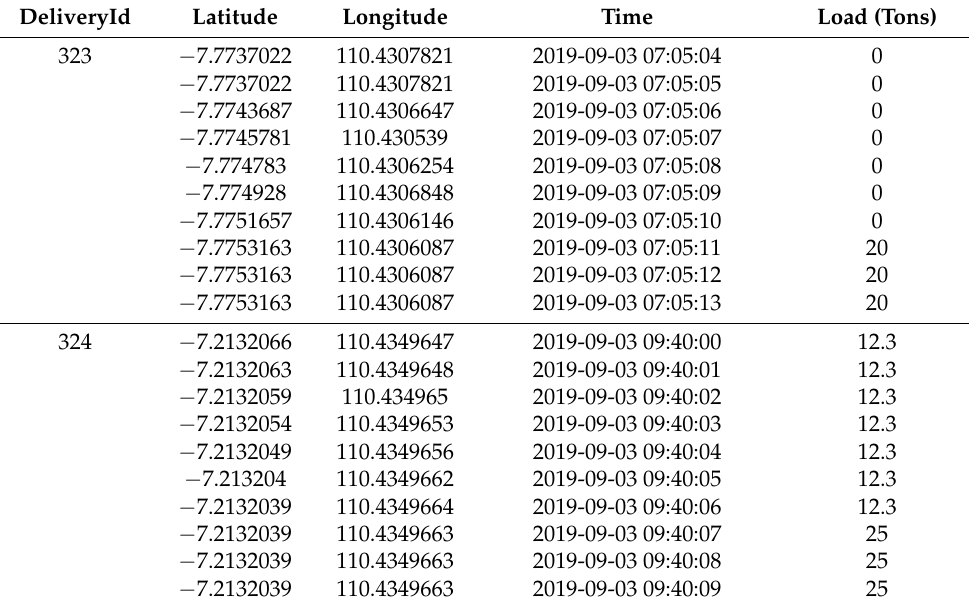
Table 1. Truck trajectories raw